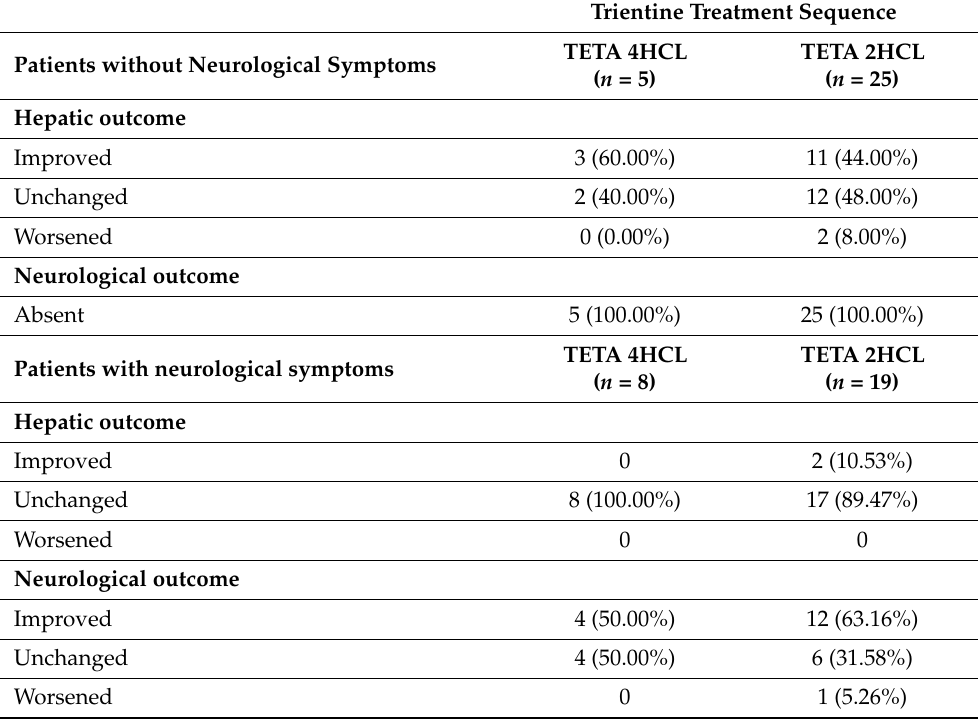
Table 3. Outcome in patients based on presence of neurological symptoms at the sequence